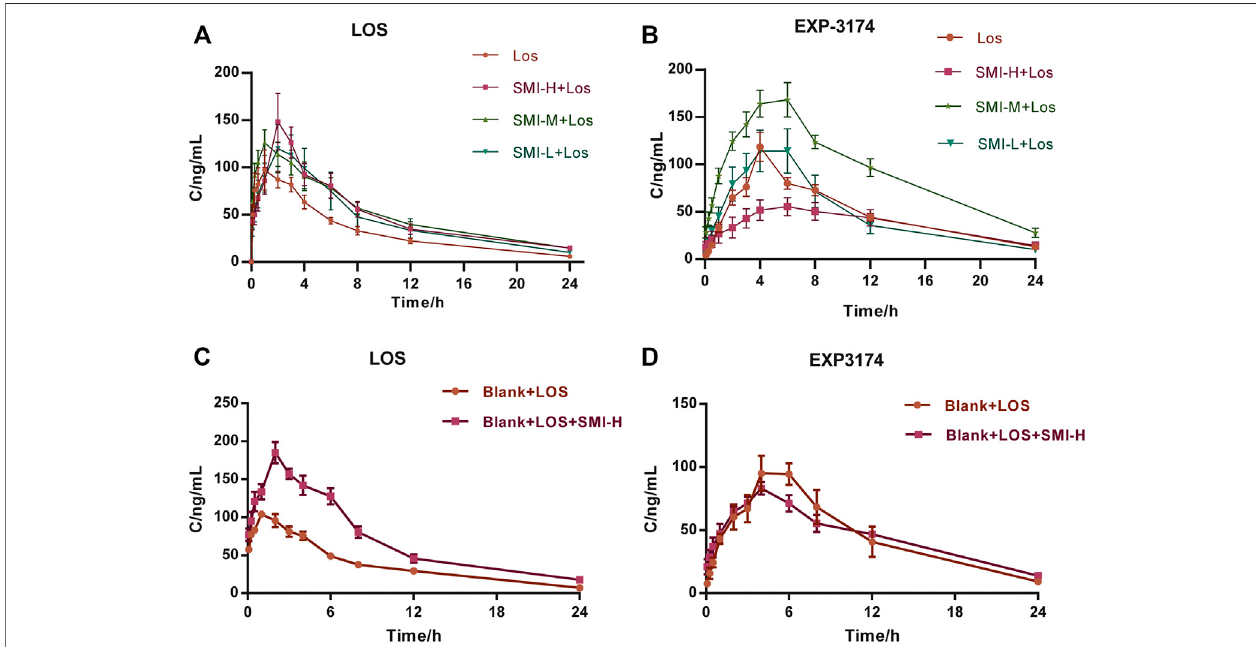
FIGURE2| Theconcentration-timecurvesofLOSandEXP3174with (A,B) andwithout (C,D) L-NAMEtreatment.ModelgroupwastreatedwithL-NAME60 mg kg − 1 . d − 1 intragastrically;SMIhigh-dosegroup(SMI-Hgroup)receivedSMI6 ml kg − 1 .d − 1 intailveininjection;LOSgroupwasgivenLOS10 mg kg − 1 .d − 1 intragastrically;LOSplus SMI high-dose group (SMI-H + LOS group), LOS plus SMI medium-dose group (SMI-M + LOS group) and LOS plus SMI low-dose group (SMI-L + LOS group) were respectively given SMI 6 ml kg − 1 . d − 1 , 4 ml kg − 1 . d − 1 , 2 ml kg − 1 . d − 1 in tail vein injection, based on LOS 10 mg kg − 1 . d − 1 intragastrically. Blank + LOS received LOS 10 mg kg − 1 .d − 1 byintragastricadministrationwithoutL-NAMEtreatment;Blank+LOS+SMI-HgroupreceivedSMI6 ml/kg/dintailveininjectionandLOS10 mg kg − 1 .d − 1